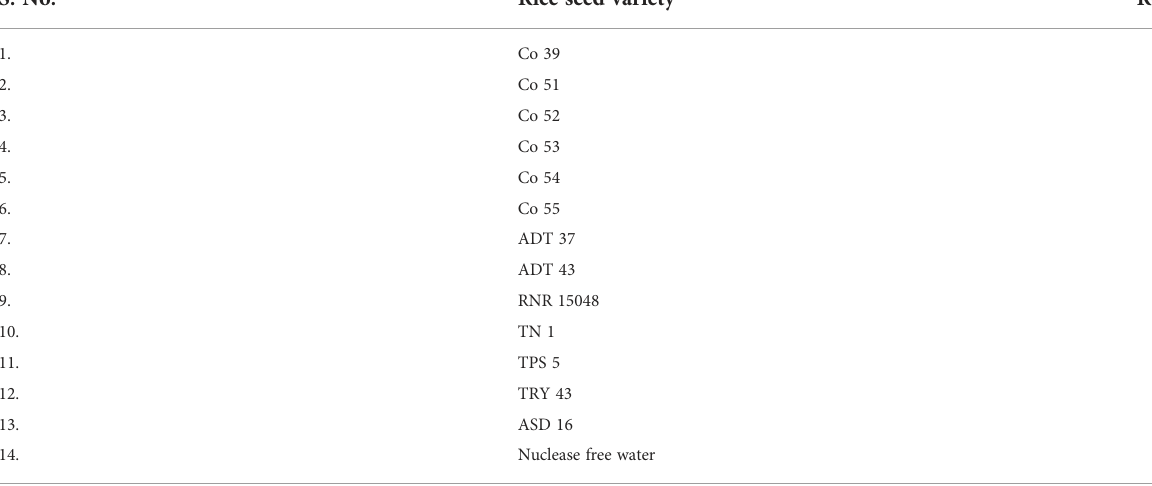
TABLE 7 Validation of LAMP assay with different varieties of